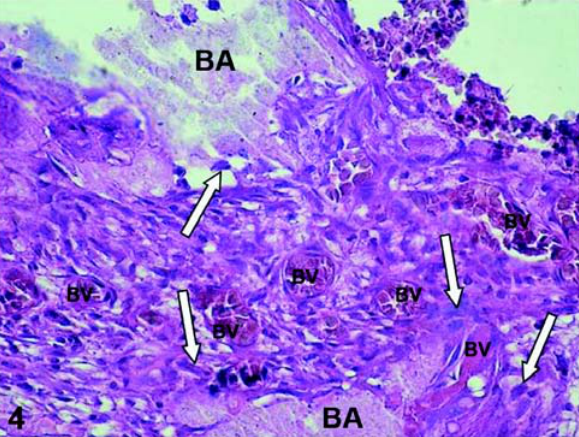
FIGURE 4- Exposed human pulp tissue capped with an adhesive system. Sixty days after the capping procedure the tooth was extracted and processed for histological evaluation of the pulp tissue. Note the presence of bonding agent (BA) on the pulp exposure site and inside of the connective tissue (BA – arrow). Intense chronic inflammatoty reaction mediated by macrophages and a number of dilated and congested blood vessles (BV) is observed. HE, ×320